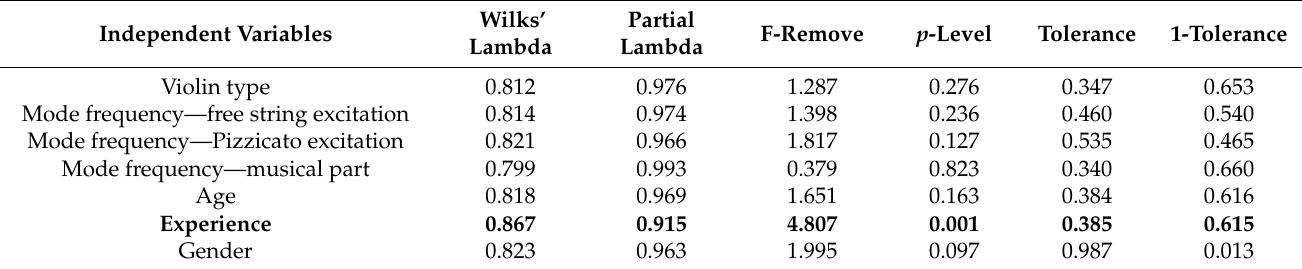
Table 4. The results of the multifactor discriminant analysis regarding warm of sound.